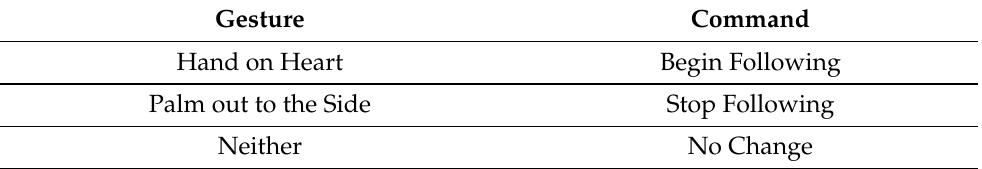
Table 1. List of visual gestures and their corresponding